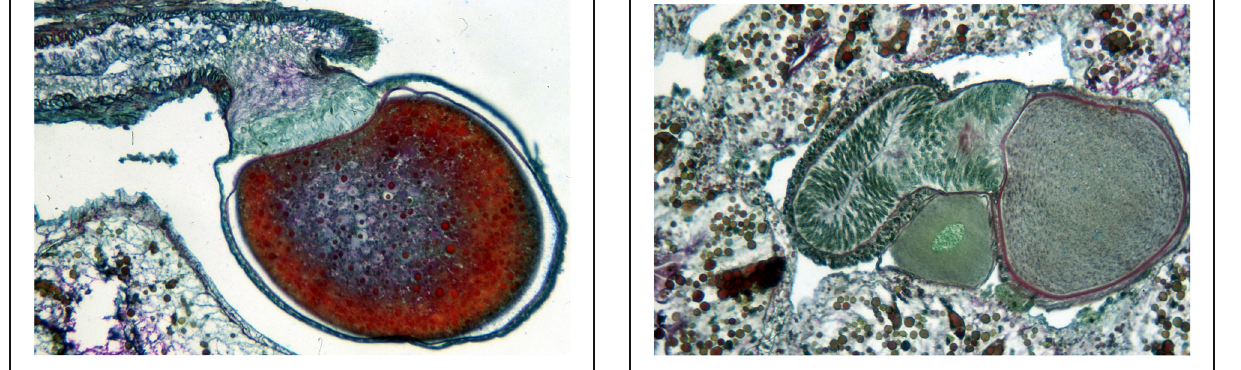
Fig. 7 Histological section showing the development of the apoikogenic buthid Centruroides barbudensis